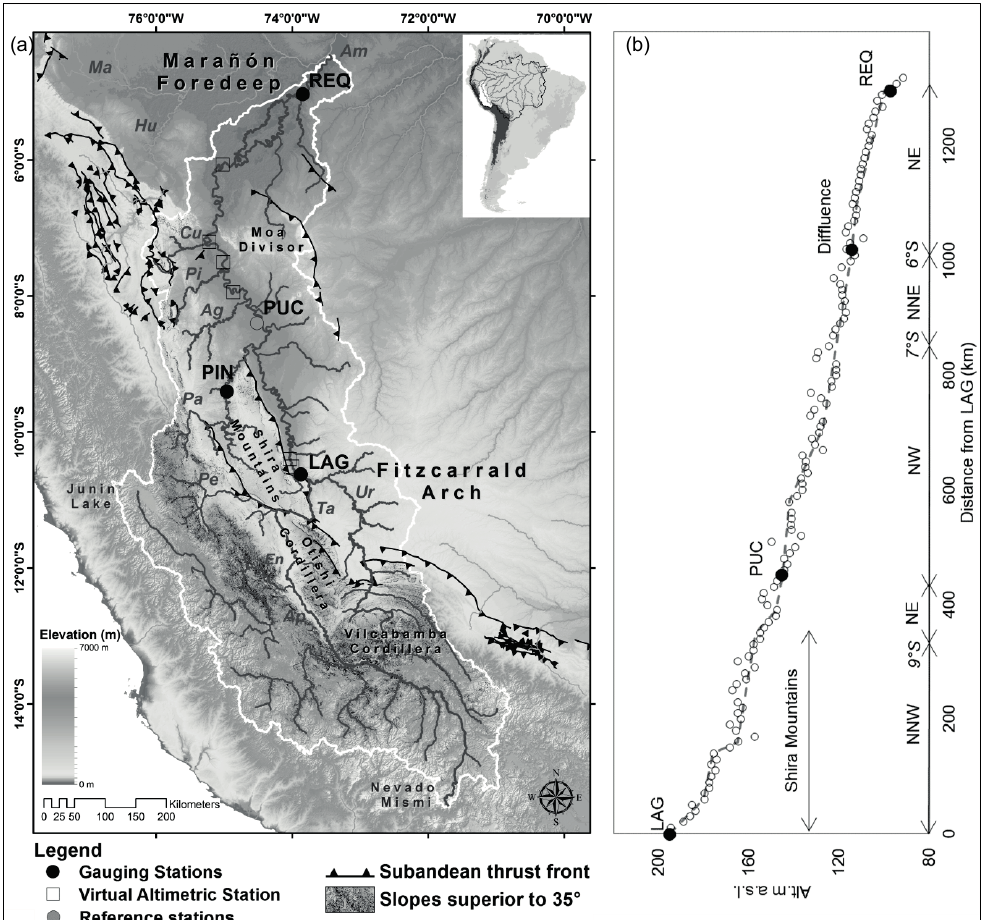
Fig. 1 (a) Location of the gauging stations in the Ucayali basin; relief data from SRTM (see Table 1 for station codes). Am, Amazon River; Ma, Marañón River, Hu, Huallaga River ; Cu, Cushabatay River ; Pi, Pisqui River; Ag, Aguaytia River; Pa, Pachitea River; Pe, Perene River; En, Ene River; Ap, Apurimac River; Ta, Tambo River; Ur, Urubamba River. (b) Slope between LAG and REQ extracted from SRTM. Direction of the main stream is indicated in the X